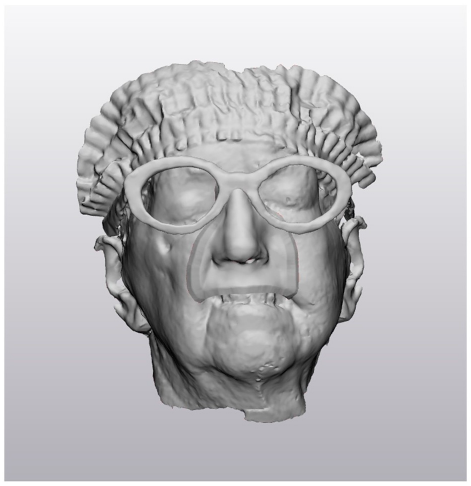
Figure 5. STL fi le of the laser-scanned eyeglasses after their positioning on the patient’s face.